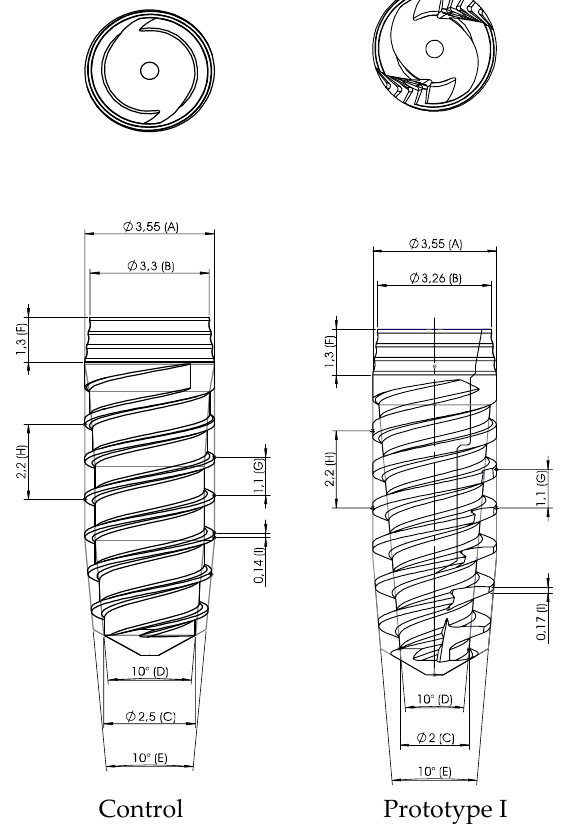
Figure 2. Control design and Prototype I with a more conical core, increased thickness of threads, and the introduction of helicoidal